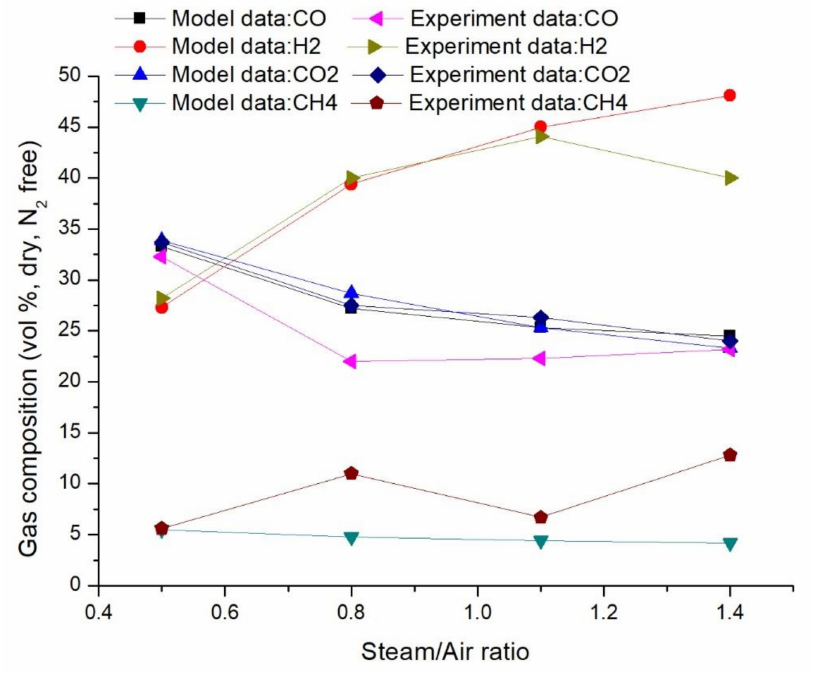
Figure 5. Syngas distribution comparison under di ff erent steam-to-air ratios.